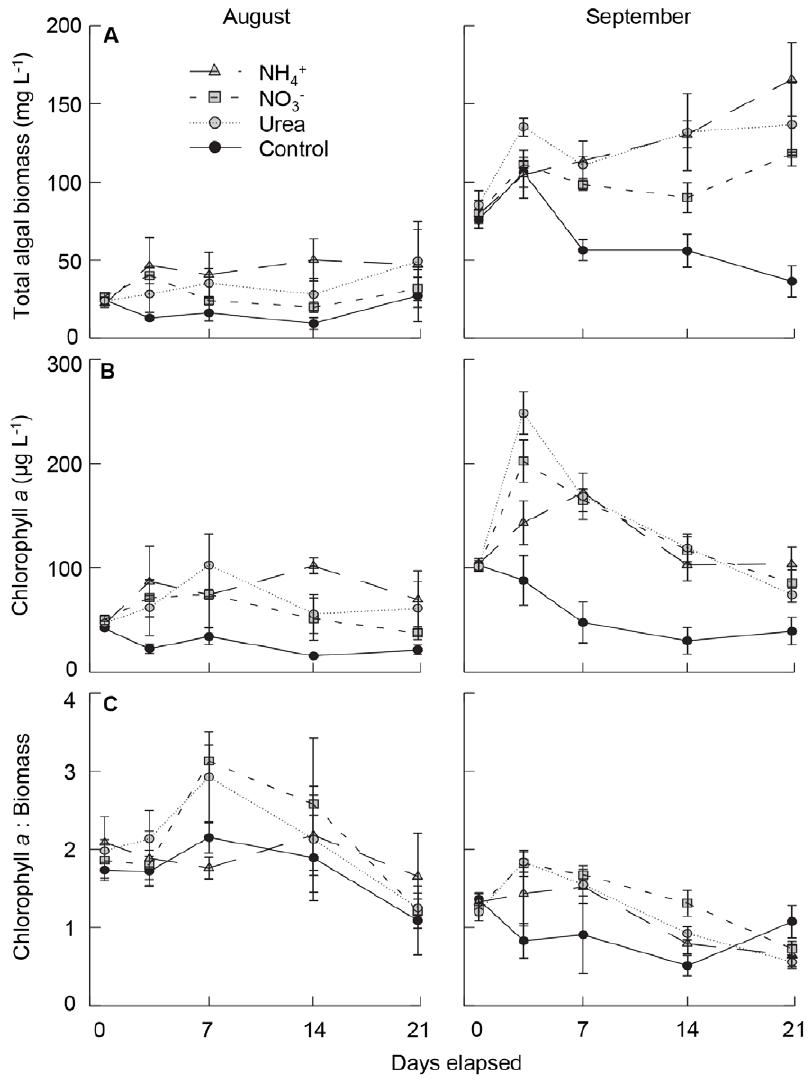
Figure 2. Biomass responses of total algal response to fertilisation with nitrogen in mesocosms conducted in August and September. Time series include; a) total phytoplankton biomass (mg wet mass L 2 1 ), b) Chl a ( m g L 2 1 ) and c) the ratio of Chl a : total phytoplankton biomass. Symbols represent mean and standard error ( 6 SE, n =3) for each nitrogen treatment, including amendments with NH 4 + (shaded triangle, coarse dashed line), NO 3 2 (shaded square, medium dashed line) and urea (shaded circle, fine dashed line), as well as unamended (control) mesocosms (solid circle, solid line).